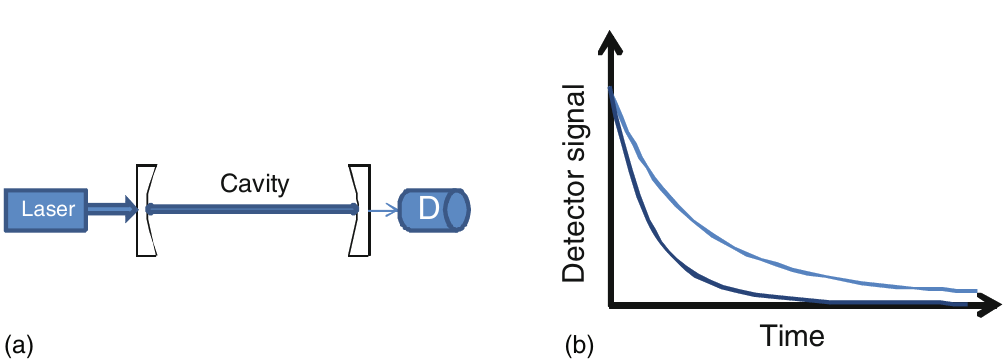
Fig. 5. (a) Schematic of CRDS apparatus. (b) Ring down signal in the absence (upper curve) and presence (lower curve) of an absorbing